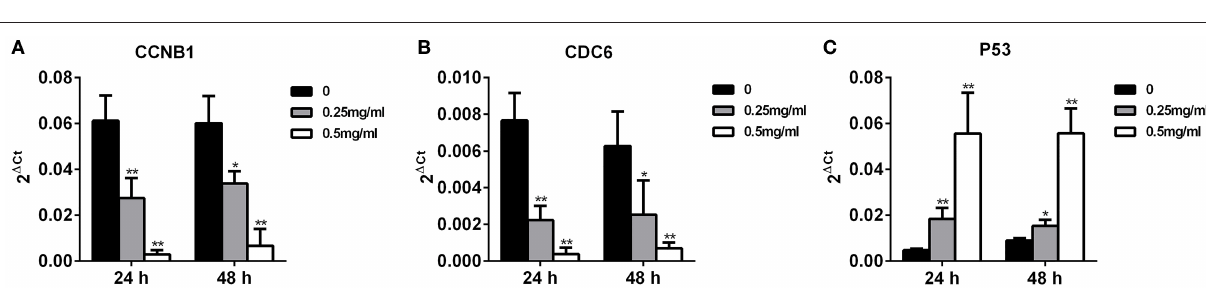
FIGURE 11 | Dose-dependent inhibitory effects of APS on the invasion and motility of BC cell (MDA-MB-231) detected by Transwell assays. Cell motility of MDA-MB-231 cell in response to APS (0, 0.25, 0.5 mg/ml) treatment. (A) Representative micrographs of cell invasion. (B) Quantitative representation of cell numbers obtained from counting in three separate experiments. * p < 0.05, ** p < 0.01 vs. control (0 mg/ml).